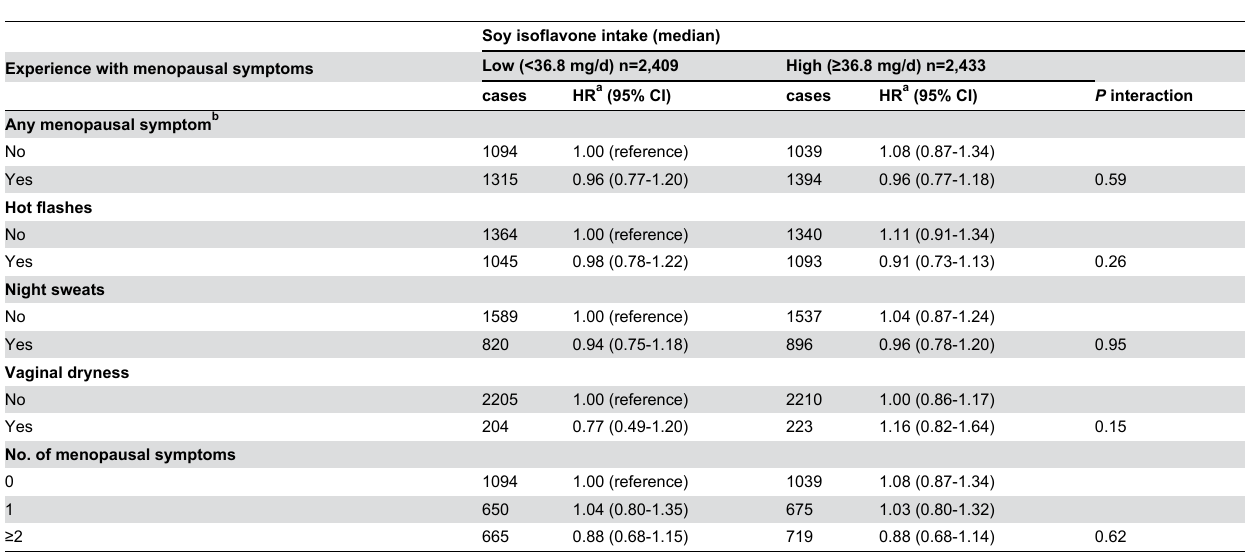
Table 6. Menopausal symptoms in association with breast cancer recurrence by soy isoflavone intake, SBCSS (n=4,842).